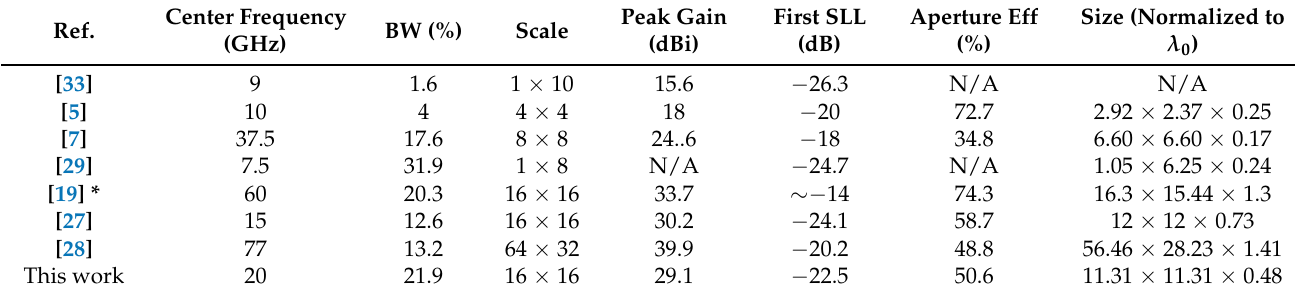
Table 3. Comparison of Previously Reported Antenna